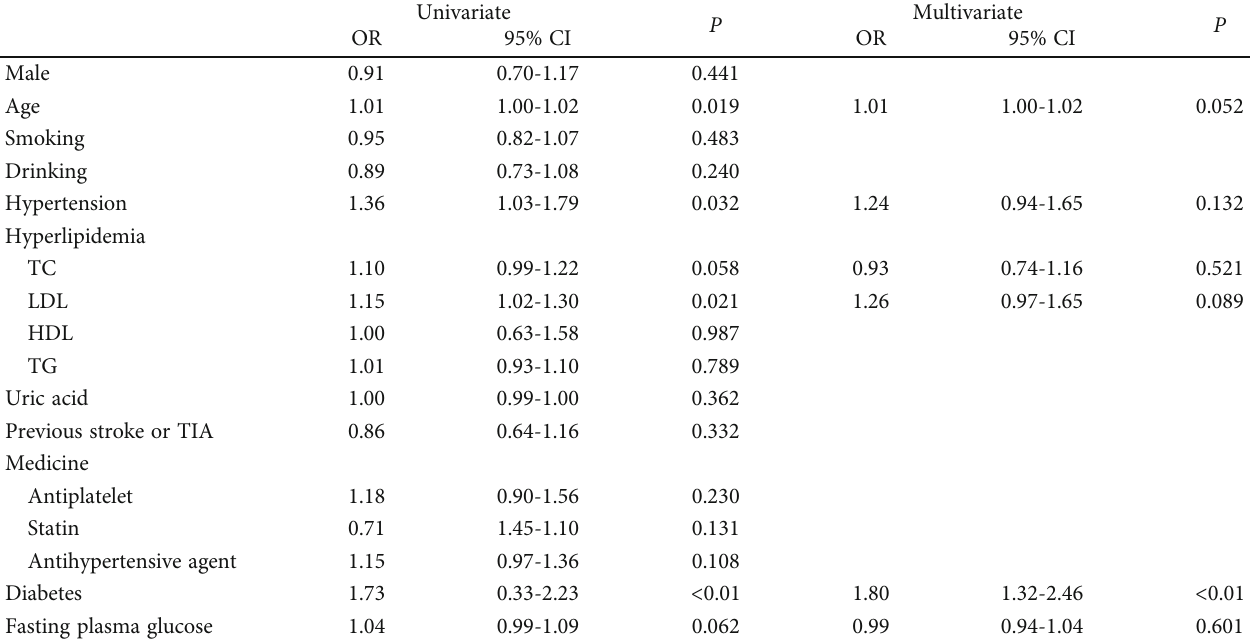
Table 4: Multivariate logistic regression of pontine infarction with SVO.